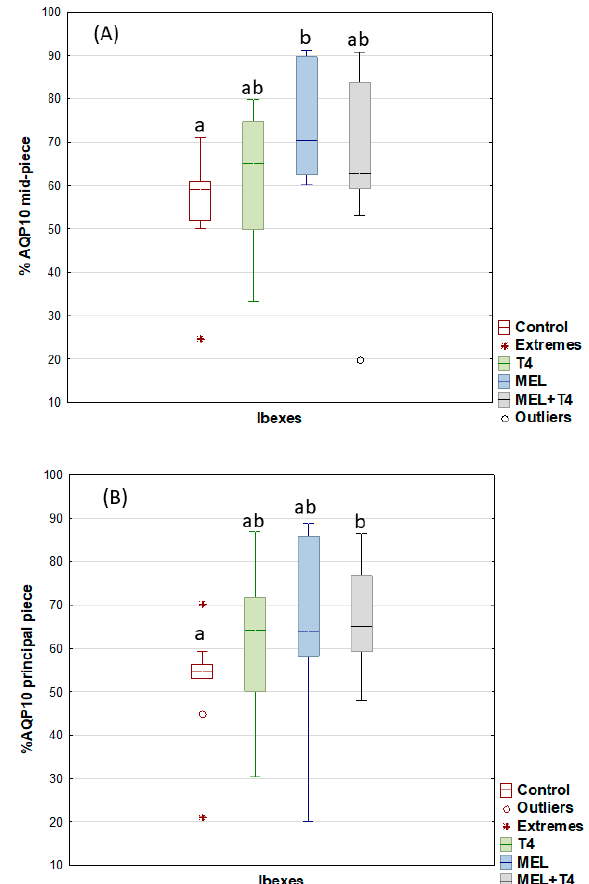
Figure 6. AQP10 expression by immunocytochemistry labelling (ICC) in midpiece ( A ) and principal piece of ibex sperm (controls (red); treated with thyroxine (T4, green); treated with melatonin implants (MEL, blue); and treated with melatonin implants plus thyroxine (MEL+T4, gray)). The boxes spread form the 1st to the 3rd quartiles. Box plots show the median (horizontal line) and spread from the 1st to the 3rd quartiles; the whiskers extend from the smallest to the largest value. Outliers are shown as circles and extremes as asterisks. Different letters (a,b) between boxplots indicate significant differences ( p < 0.01 for ( A ), and p < 0.05 for ( B